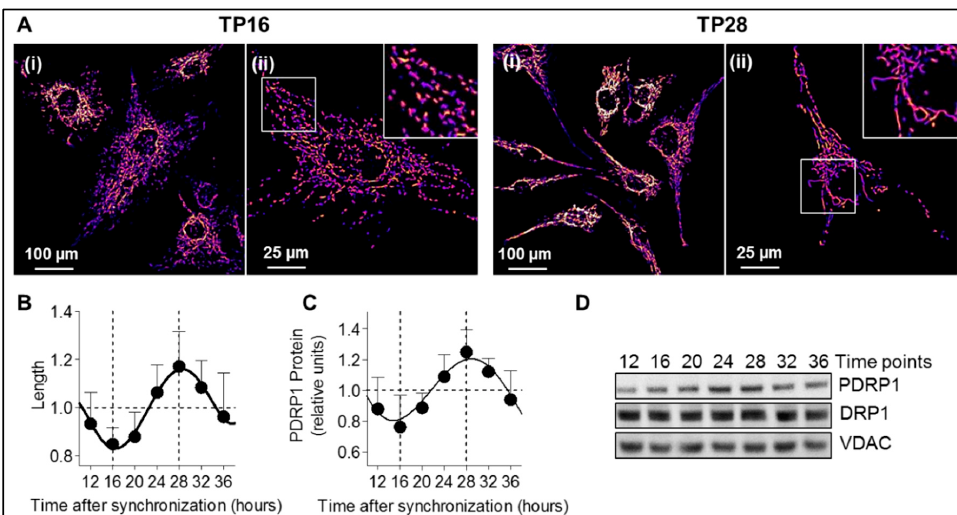
Figure 3. Mitochondrial network morphology shows a circadian rhythmicity in A172 glioma cells. ( A ) Mitochondrial network morphology assessed in synchronized A172 glioma cells transfected with mitochondrially-targeted GFP (false color “fire”) at 16 h and 28 h, corresponding to a fragmented network and a tubular network, respectively. For each representative image, a zoom-in image is shown (400%). Scale bars: 100 μ m (i) and 25 μ m (ii). The complete cycle (from time point 12 to 36) is shown in Supplementary Figure S2. ( B ) Quantification of mitochondrial length in synchronized A172 glioma cells transfected with mitochondrially-targeted GFP from 12 to 36 h post-synchronization. All data are normalized to 1 and presented as mean ± SD (two independent experiments, seven time points). About 40 images containing 3000–5000 mitochondria were analyzed per time point. ( C ) Phospho-DRP1 (PDRP1 = dynamin-related protein 1 phosphorylated at serine 637) protein level was analyzed in cell lysates from synchronized A172 glioma cells by immunoblotting. Time points from 12 to 36 h post-synchronization are shown. All data are normalized to 1 and presented as mean ± SD (three independent experiments, seven time points, n = 4–6 for each time point). ( D ) Representative immunoblots of synchronized A172 glioma cell lysates stained with antibodies specific for phospho-DRP1 (PDRP1), DRP1 (total DRP1), and VDAC (control). Time points from 12 to 36 h post-synchronization are shown.